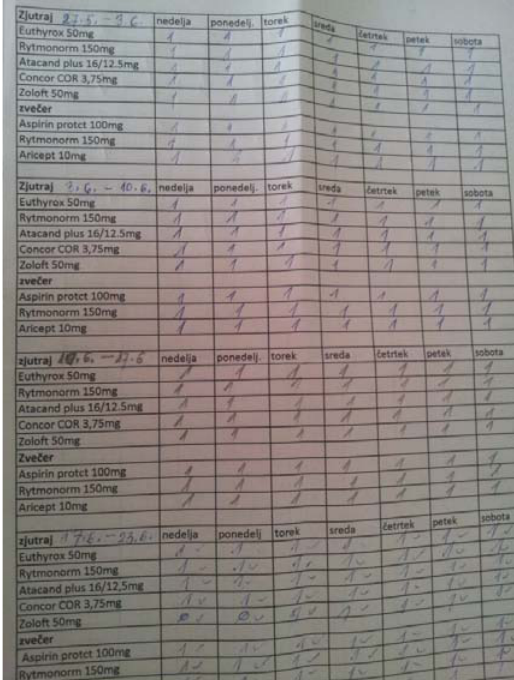
Figure 4. An example of a medicine